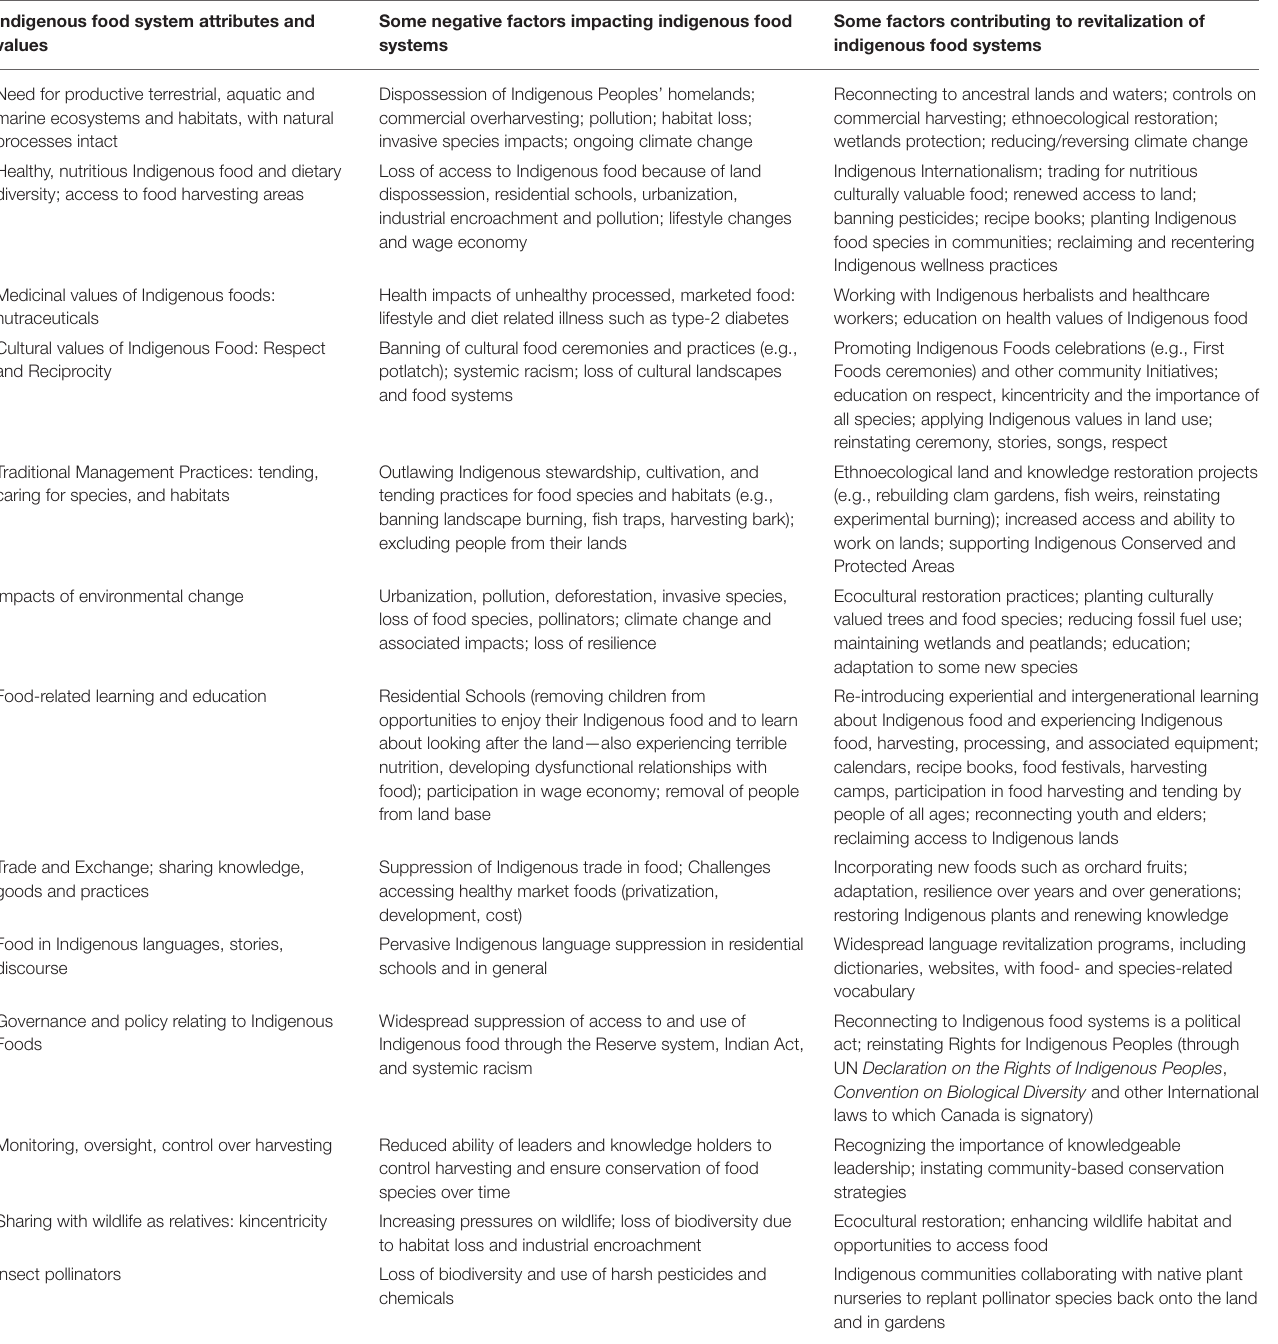
TABLE 1 | Indigenous peoples’ food systems in Northwestern North America: attributes, threats and enhancements (United Nations, 1992, 2007; Anderson, 2005; Menzies, 2006; Nabhan, 2006; Watts and Watts, 2007; Brown et al., 2009; Kuhnlein et al., 2009, 2013; Krohn and Segrest, 2010; Corntassel and Bryce, 2012;